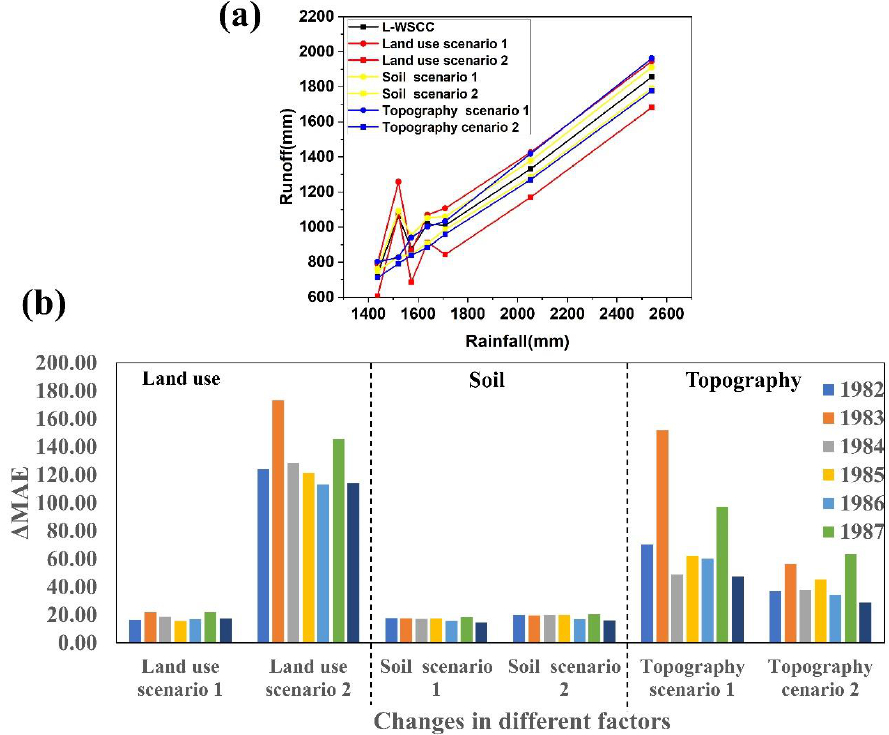
Figure 7. Simulated changes with different factor changes. ( a ) Impact of the different factors change on the relationship between rainfall and runoff. The lines above and below the L-WSCC line represent different directions of influence on runoff, and the intervals between the lines with the same color indicate the degree of influence of different factors on runoff. ( b ) The ΔMAE in different scenarios.